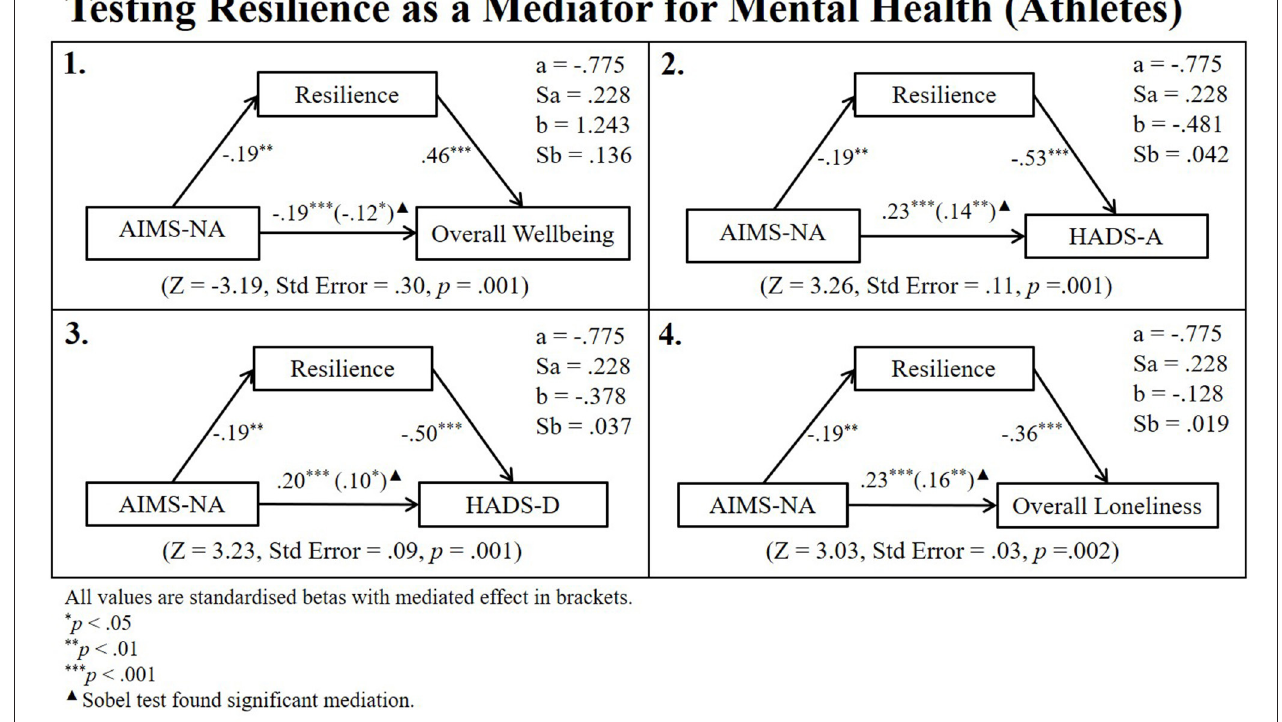
FIGURE 4 | Regression path diagram testing resilience as a mediator for athlete sample.